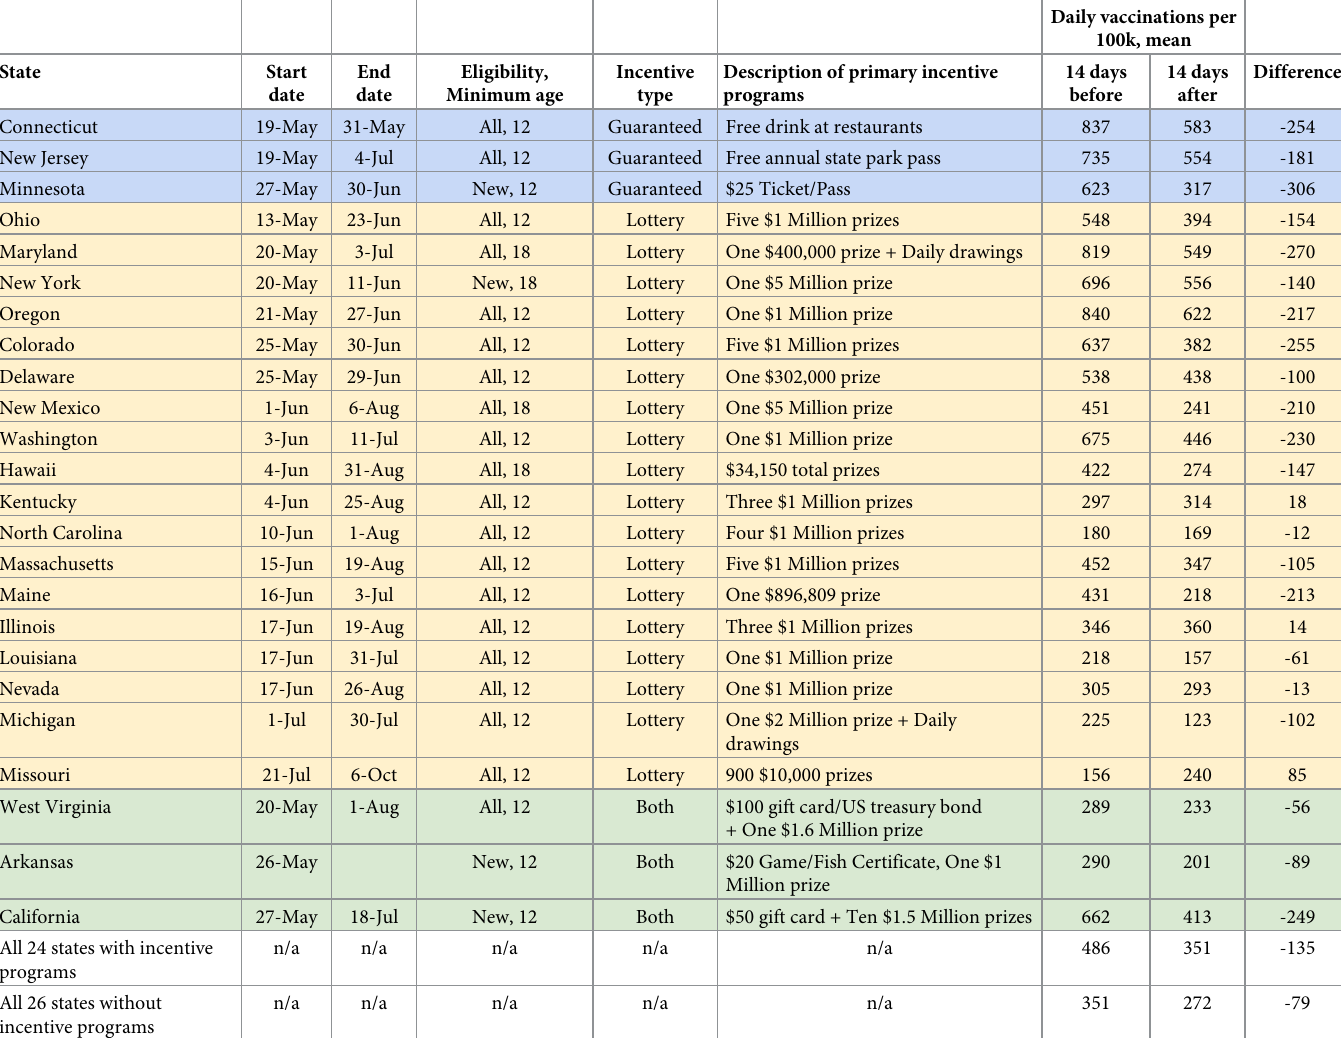
Table 1. Summary of analyzed statewide incentive programs for COVID-19 vaccination and trends in daily vaccination rates.